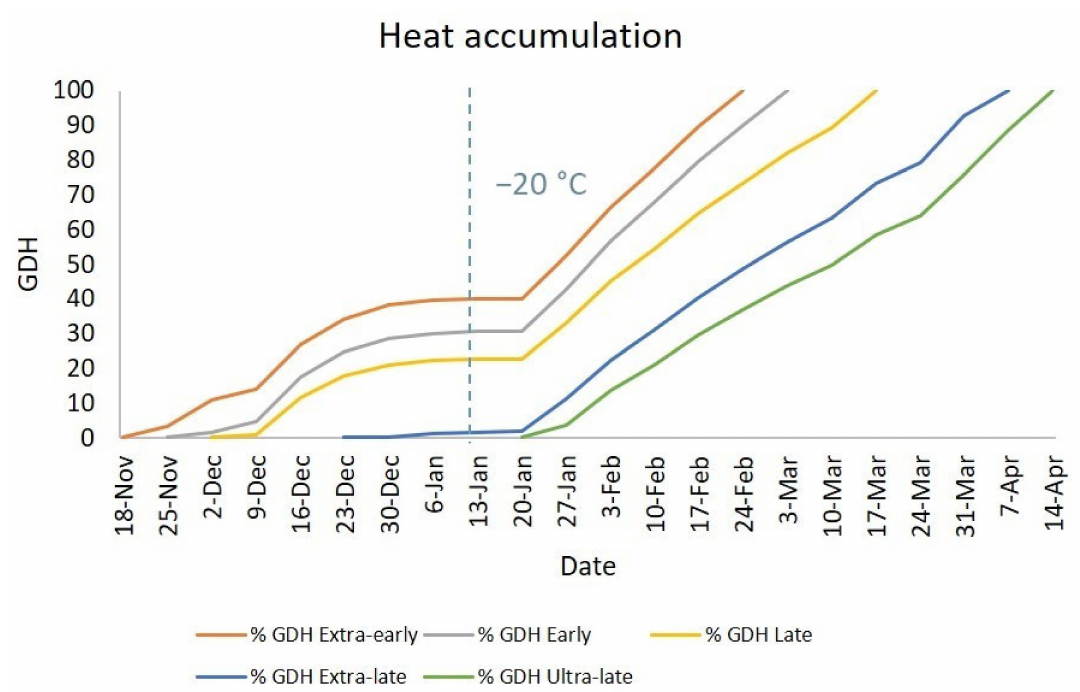
Figure 3. Percentages of heat requirements needed to flower (GDH) met by each cultivar group during the winter of 2020/21 in Barrax. Each cultivar group started to accumulate heat once they reached endodormancy release and finished flowering. The frost date (12 January) is marked with a blue dashed